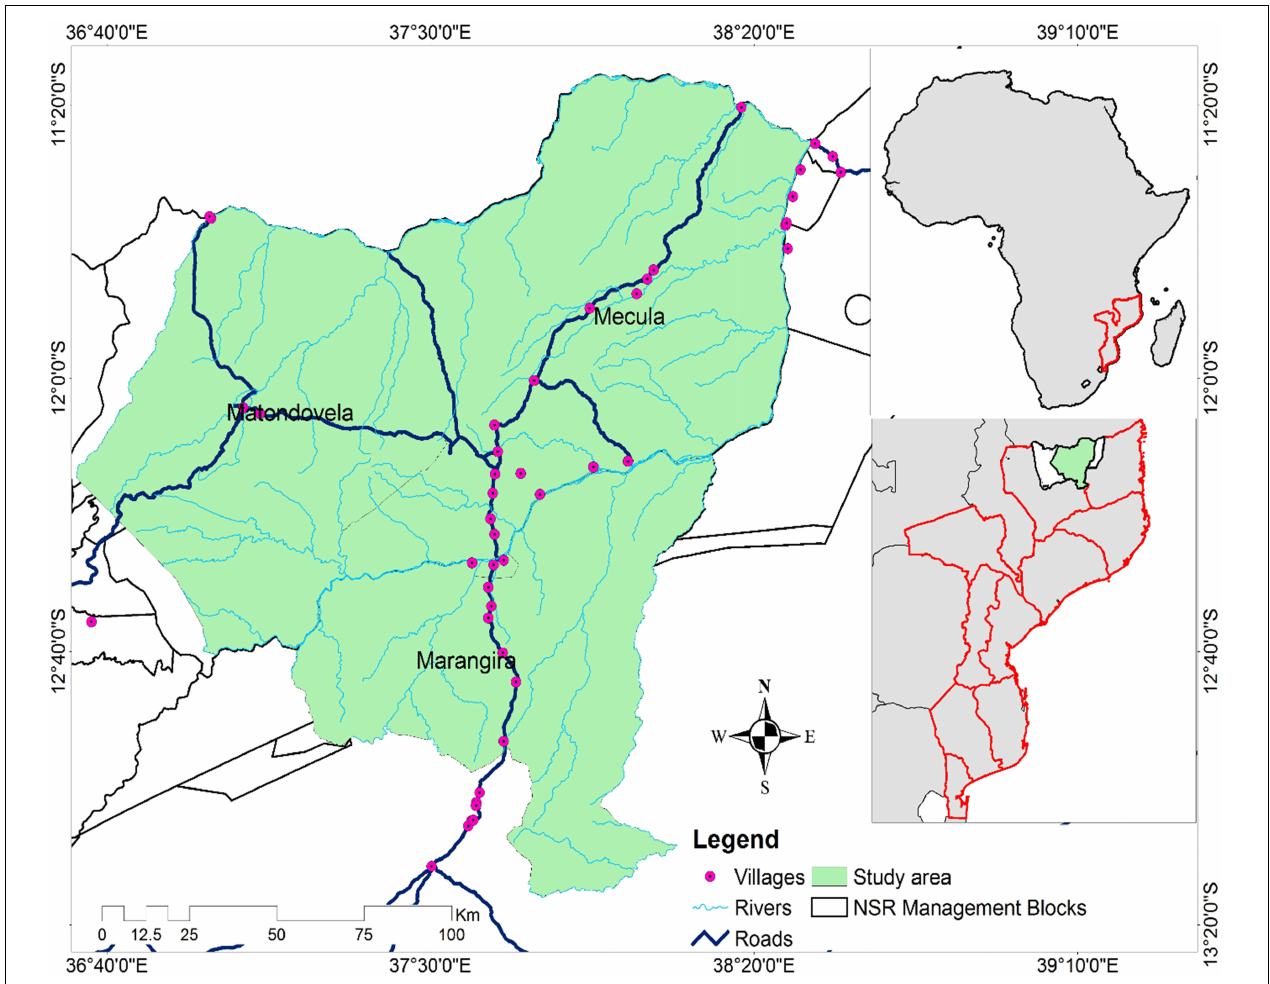
FIGURE 1 | The map showing the study